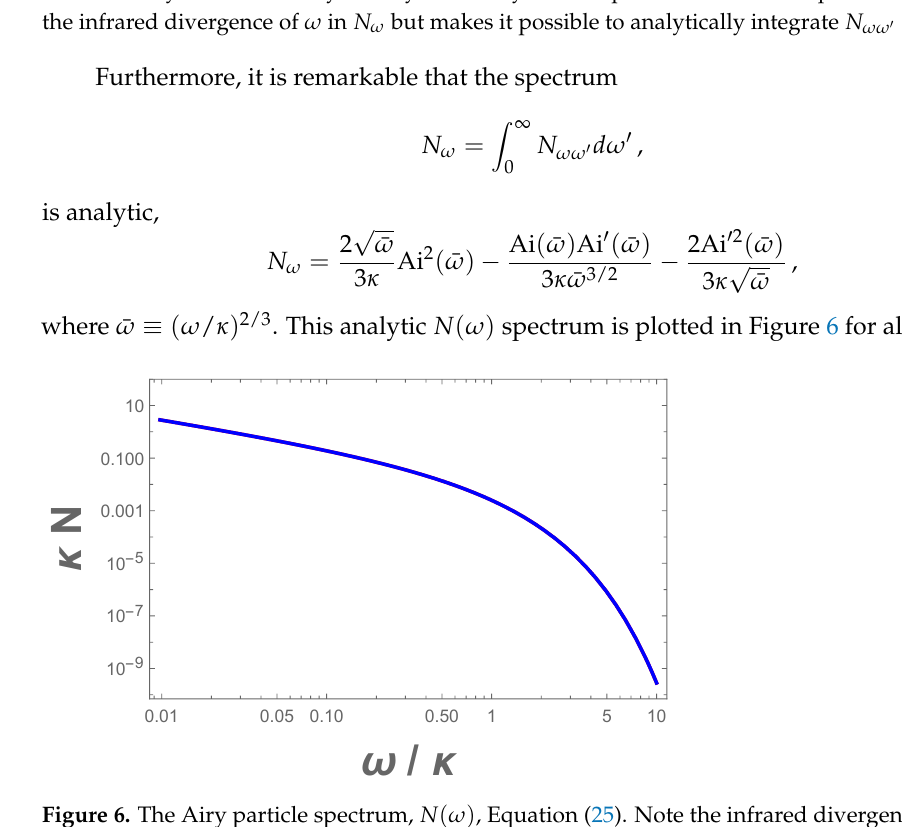
Figure 6. The Airy particle spectrum, N ( ω ) , Equation (25). Note the infrared divergence at ω → 0; the soft particle divergence results in infinite total particle count characteristic of asymptotic coasting mirrors. Larger maximum acceleration as measured by κ results in more particles for a wider range of frequencies, i.e., N scales as 1/ κ as seen by the κ N curve plotted vs. ω / κ